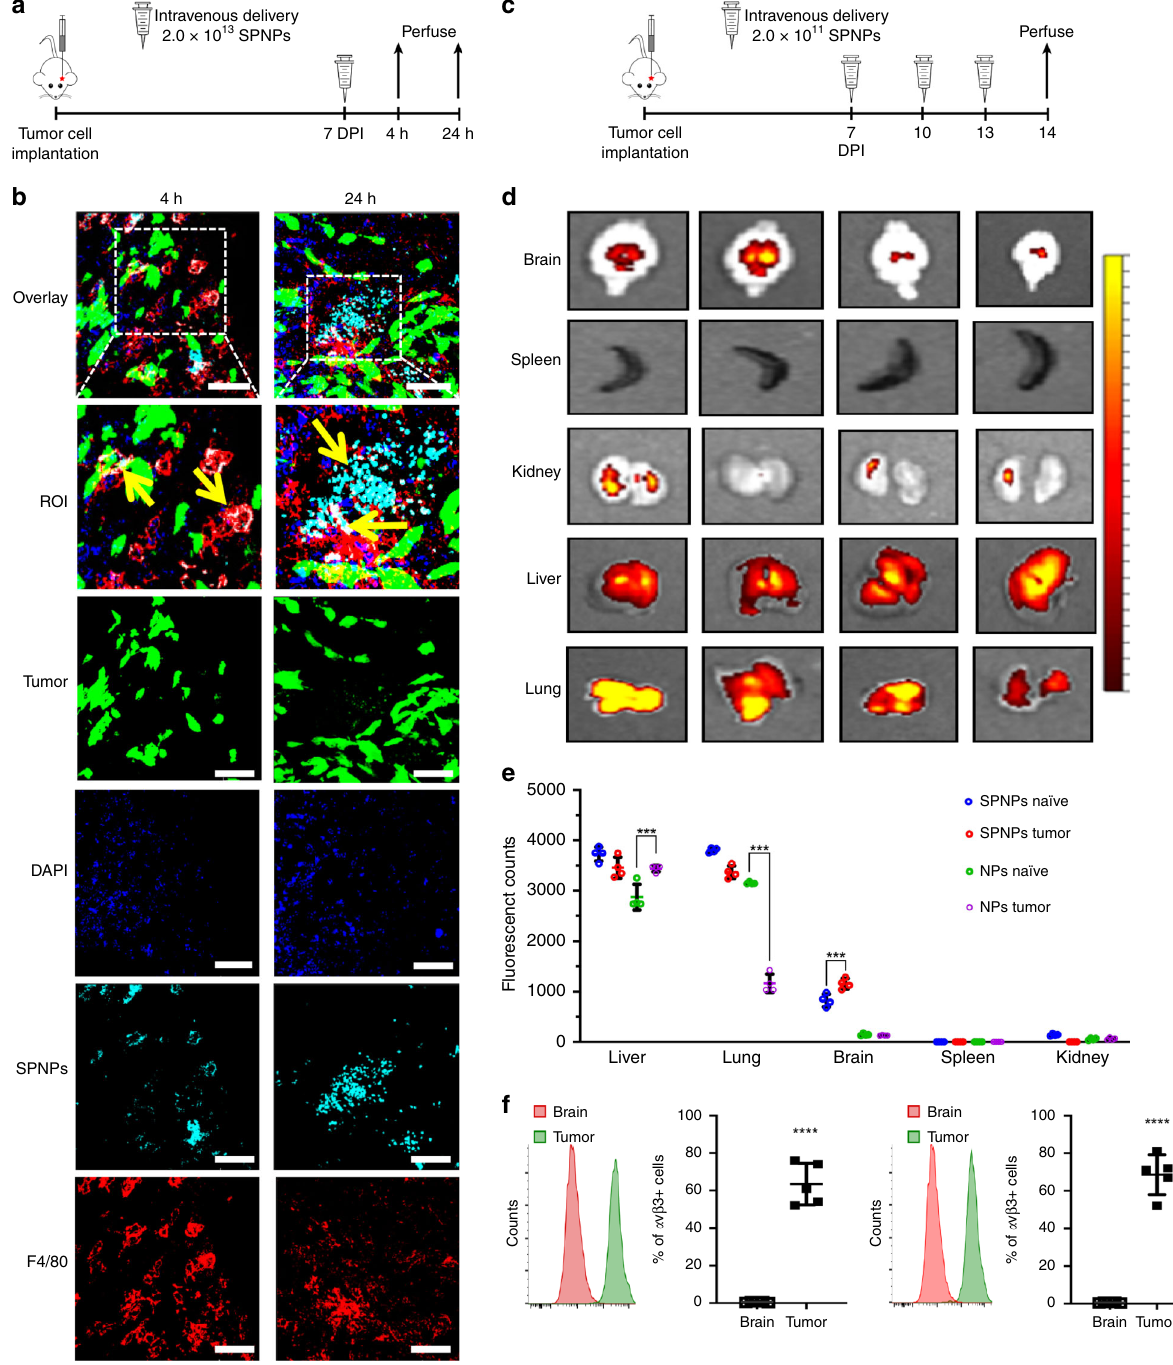
Fig. 2 in vivo brain targeting and biodistribution of SPNPs. a Timeline for the tumor-targeting study. Mice were IV administrated a single dose of 2.0 × 10 13 SPNPs or empty NPs (no iRGD) via the tail vein seven days post GL26 tumor cells implantation. Confocal imaging of sectioned brains was performed 4 and 24 h post particle administration. b Alexa Fluor 647 labeled SPNPs (cyan) colocalize (indicated with yellow arrows) with macrophages (red) and tumor cells (green, mCitrine). Notably less NPs are observed in the tumor microenvironment 4 h post systemic delivery compared to 24h. Representative images from a single experiment consisting of three biological replicates per group are displayed. Scale bars = 50 µ m. c Timeline representation of the biodistribution study. Mice were IV administered 2.0 × 10 11 SPNPs or empty NPs 7, 10, and 13 days post tumor cell implantation or saline injection. d Fluorescence imaging of tumor-naive and tumor-bearing mice organs sacri fi ced at 24 h post fi nal NP delivery. e Quantitative analysis of NP biodistribution within the tumor and peripheral organs. Data are presented as mean values ± s.d. ( n = 4 biological replicates, two-way ANOVA; *** p < 0.0001). f Quantitative fl ow cytometry results of av β 3 and av β 5 integrin expression in normal brain tissue and GL26 tumors. Data are presented as mean values ± s.d. ( n = 5 biological replicates; two-tailed unpaired t -test; **** p <